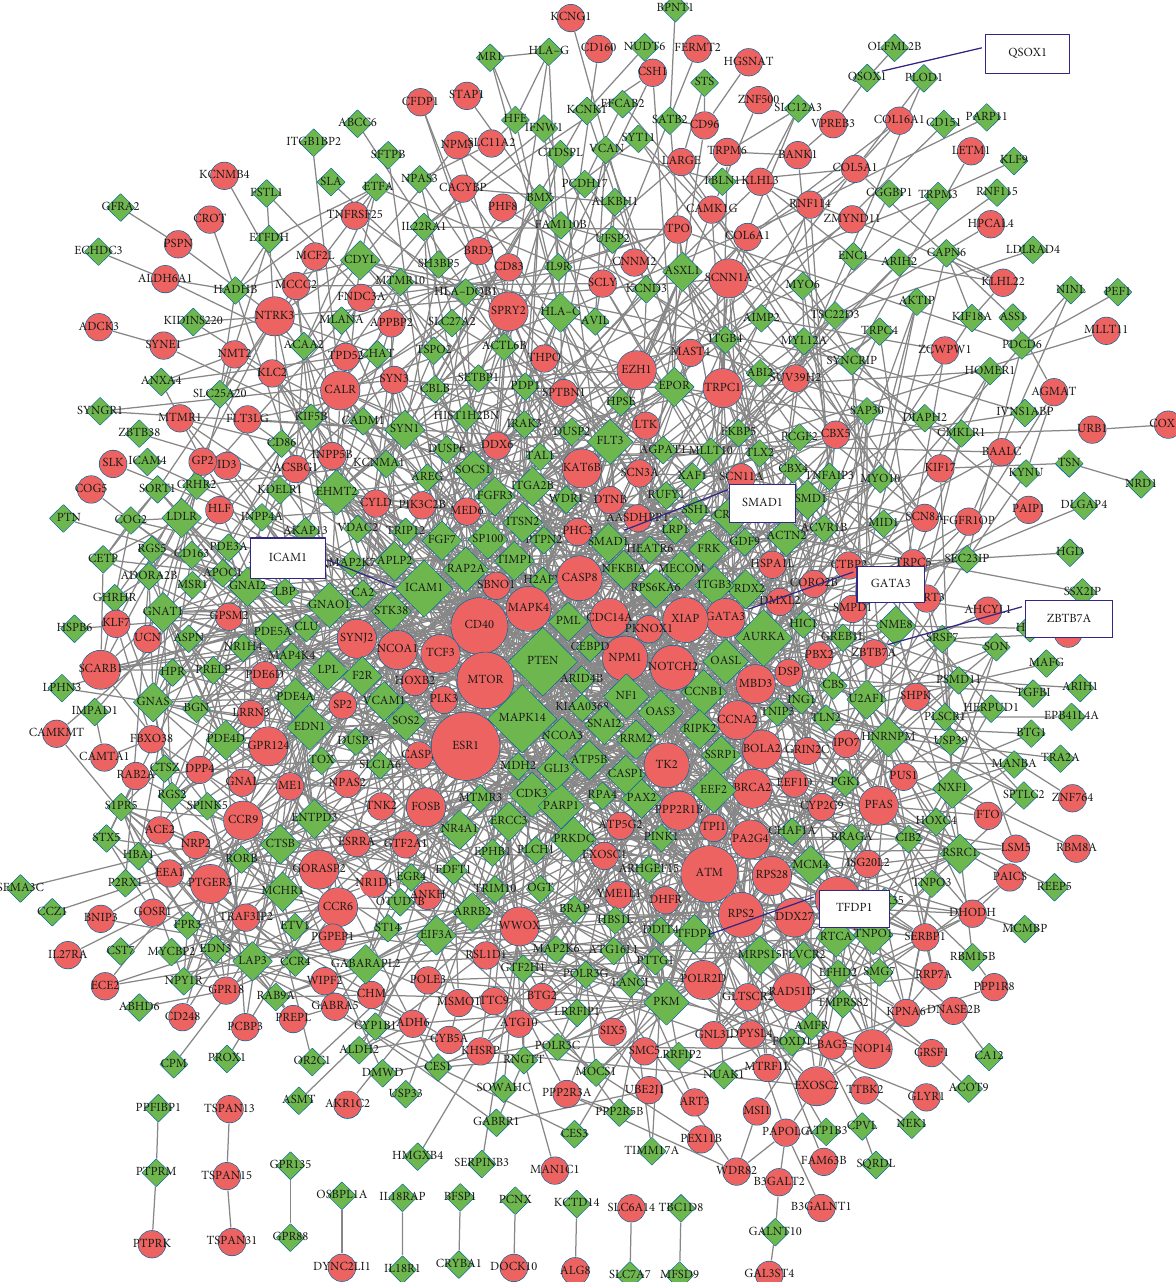
Figure 3: The protein-protein interaction (PPI) network of differentially expressed genes (DEGs). Red circles represent upregulated DEGs, and green diamonds represent downregulated